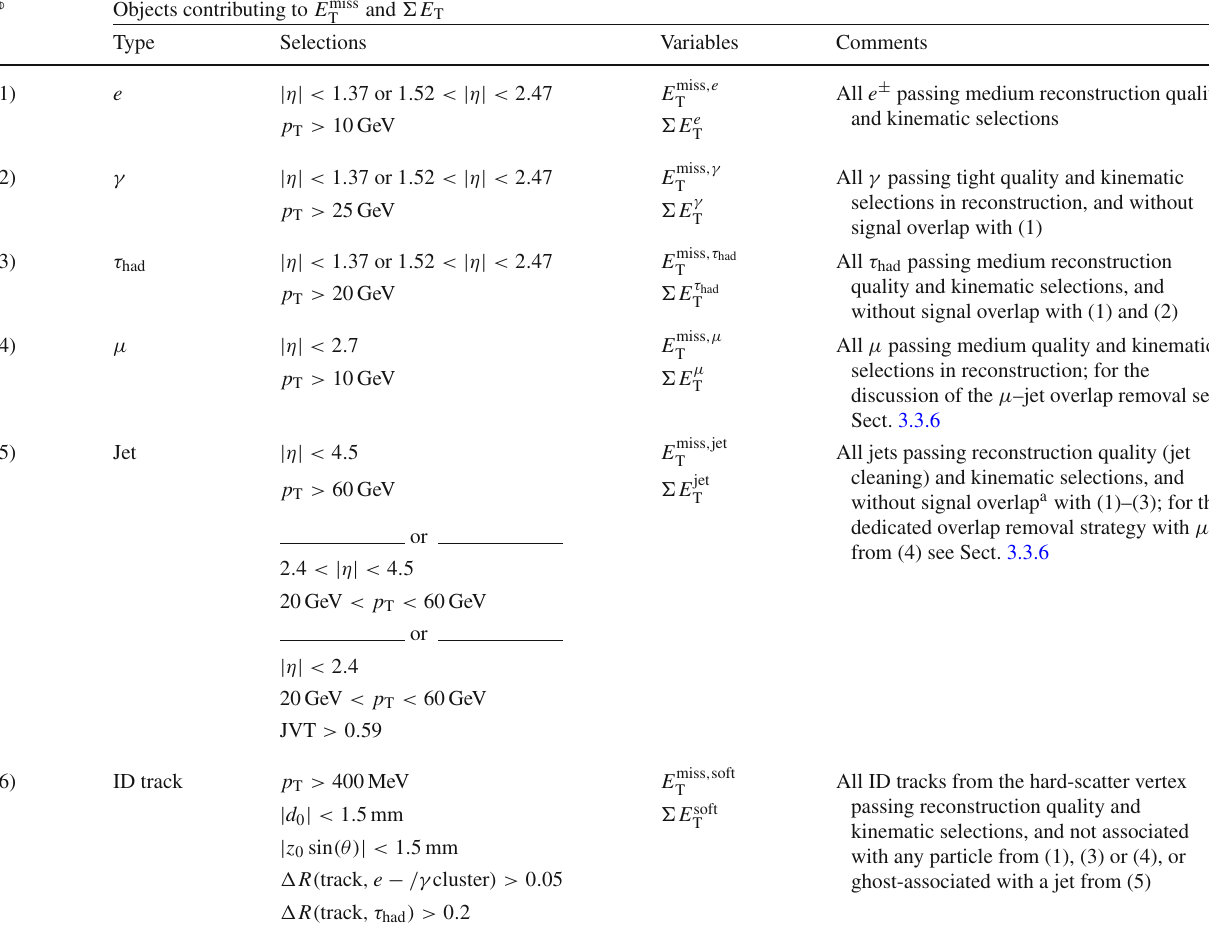
Table 1 Overview of the contributions to E miss bution. The soft-event contribution is constructed at the lowest priority and (cid:10) E T from hard T (6), after all hard objects are considered. The transverse (longitudinal) objects such as electrons ( e ), photons ( γ ), hadronically decaying τ -leptons ( τ μ ), and jets, together with the signals for the impact parameter d 0 ( z 0 sin (θ) ) used to select the ID tracks contributing had ), muons ( soft term. The configuration shown is the one used as reference for the to E miss , soft and (cid:10) E soft in P = ( 6 ) is measured relative to the hard- T T performance evaluations presented in this paper. The table is ordered scatter vertex. All variables are explained in Sect. 3.2. The angular (cid:2) descending in priority P of consideration for E miss reconstruction, with ((cid:9)η) 2 + ((cid:9)φ) distance (cid:9) R between objects is defined as (cid:9) R = T (1) being the first and (5) being the last calculated hard-object contri-